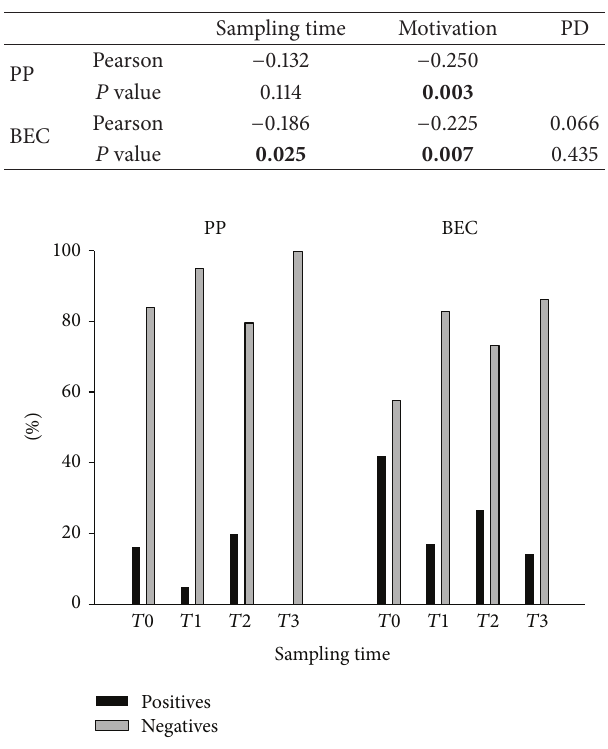
Figure 1: Distribution of positivity divided by site and sampling time.